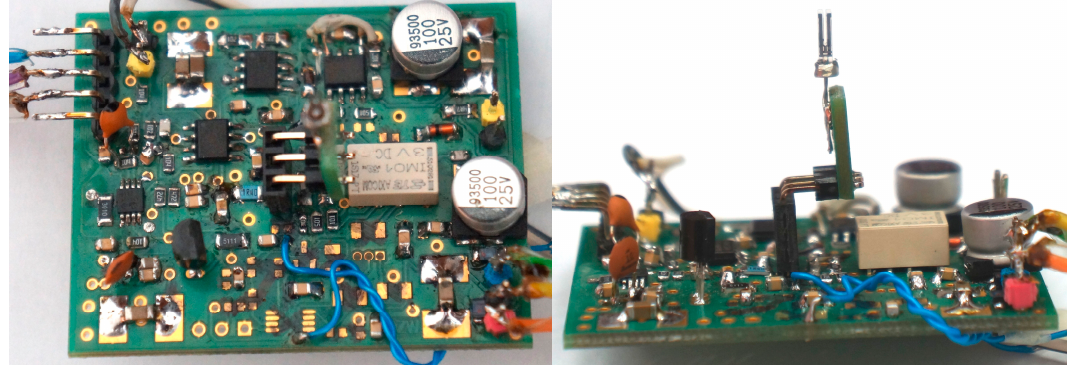
Figure 14. Photos of the assembled preamplifier with QTF used for measurements.